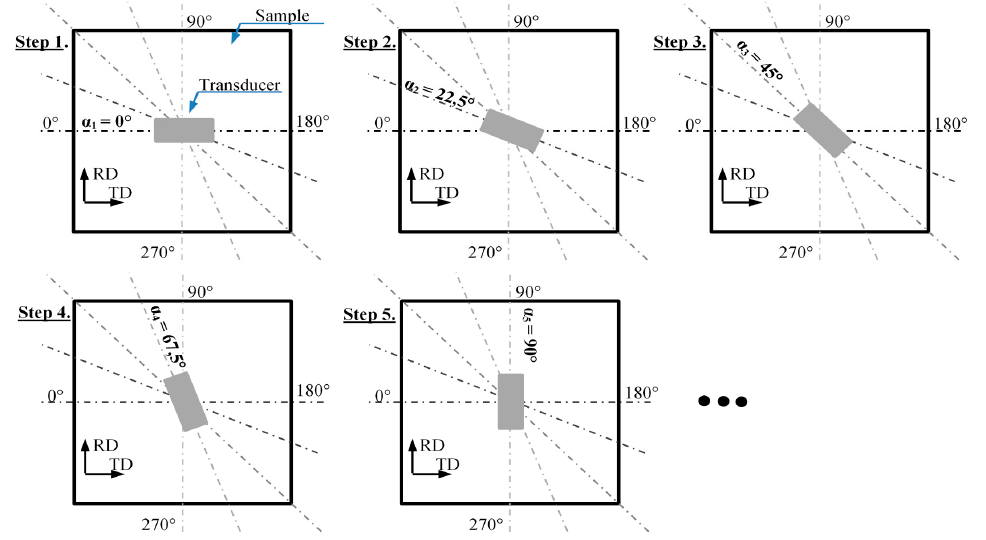
Figure 2. View of the first 5 successive steps of the transducer alignment at a given position on the sample.